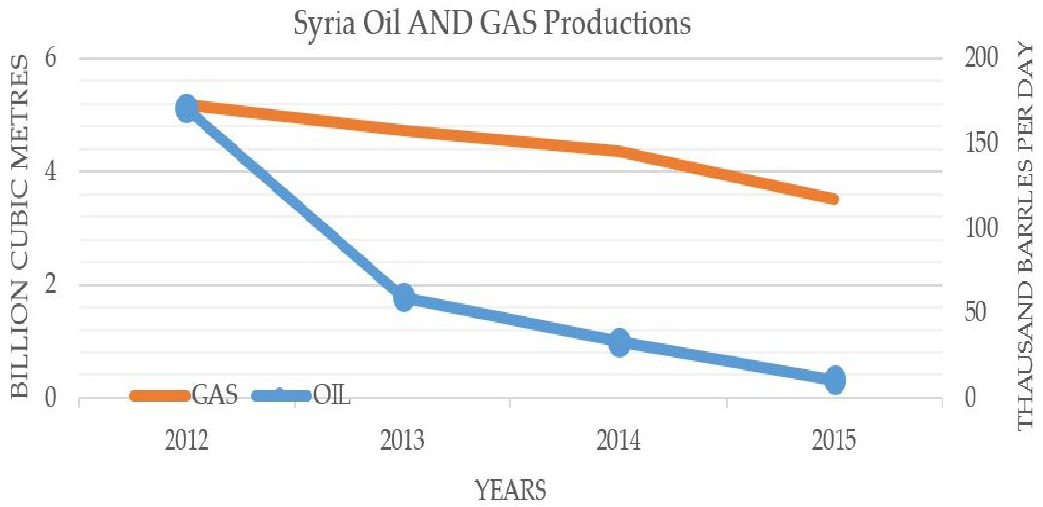
Figure 5. Syria’s oil and gas production (2012–2015) based on data of the BP Statistical Review of World Energy [4] and U.S. Energy Information administration (EIA) [16].